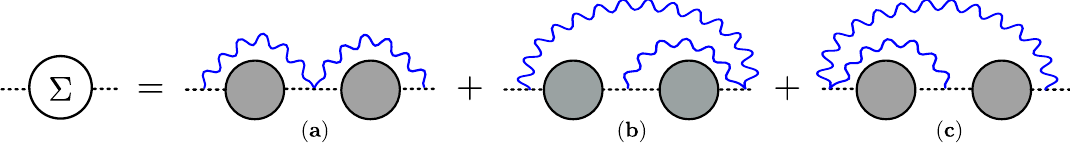
Figure 2 . The Schwinger-Dyson equation for scalar self-energy Σ( p ) . Here the filled blob represents the exact propagator ∆ ( p ) , such that ∆ − 1 ( p ) = p 2 − Σ( p )